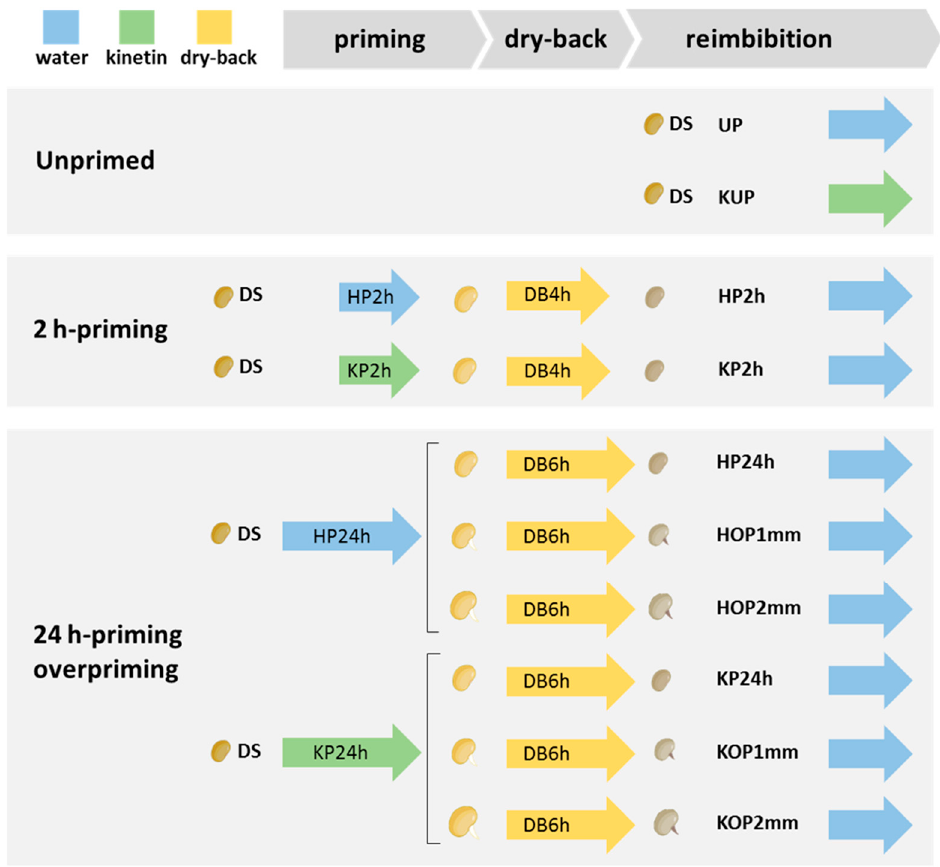
Figure 1. Overview of the experimental system aimed to compare the effects of short (2 h) and prolonged (24 h) hydropriming and kinetin-mediated hormopriming on M. truncatula and M. sativa seeds, including mild (radicle protrusion 1 mm) and severe (radicle protrusion 2 mm) overpriming conditions. Imbibition steps carried out in water are indicated in blue, imbibition steps carried out in presence of 0.5 mM kinetin are indicated in green, and dry-back steps are indicated in yellow. UP, water-imbibed unprimed seeds; KUP, kinetin-imbibed unprimed seeds; HP2h, 2 h-hydroprimed seeds; KP2h, 2 h-hormoprimed seeds; HP24h, 24 h-hydroprimed seeds; KP24h, 24 h-hormoprimed seeds; HOP1mm, hydroprimed seeds with 1 mm radicle protrusion; KOP1mm, hormoprimed seeds with 1 mm radicle protrusion; HOP2mm, hydroprimed seeds with 2 mm radicle protrusion; KOP2mm, hormoprimed seeds with 2 mm radicle protrusion; DB4h, 4 h-dry-back; DB6h, 6